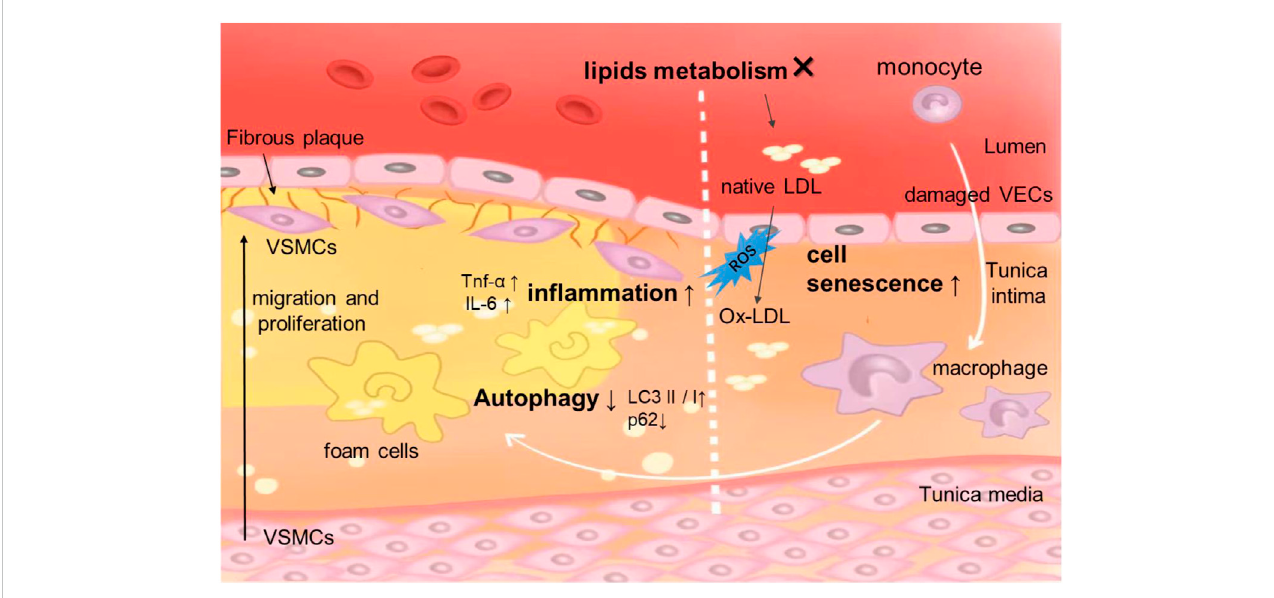
FIGURE 1 Schematic representation of the pathogenesis of AS. The damage of endothelial cells is the initial lesion of atherosclerosis. Endothelial cell damage that can be caused by disorders of lipid metabolism, monocytes/macrophages, foam cell formation release more in fl ammatory factors. VECs, VSMCs, macrophages are involved in the process of autophagy. In AS, cell senescence often occurs in VECs,